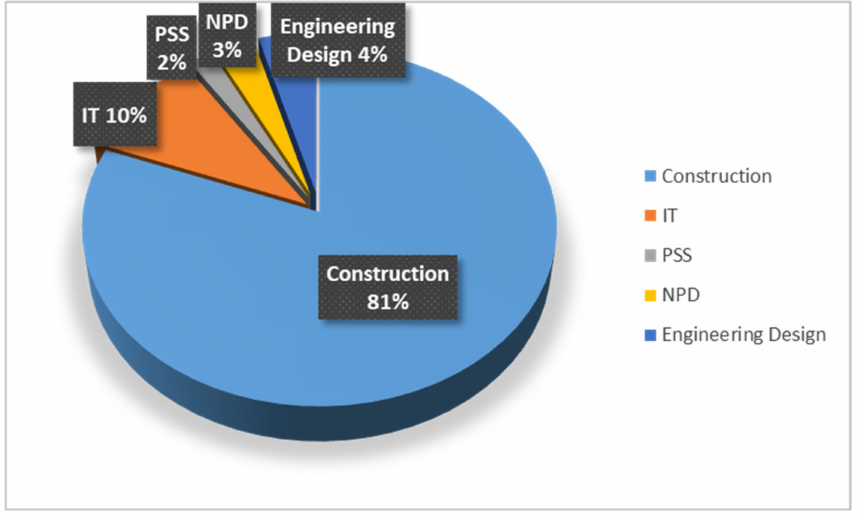
Figure 3. Research sectors used in the